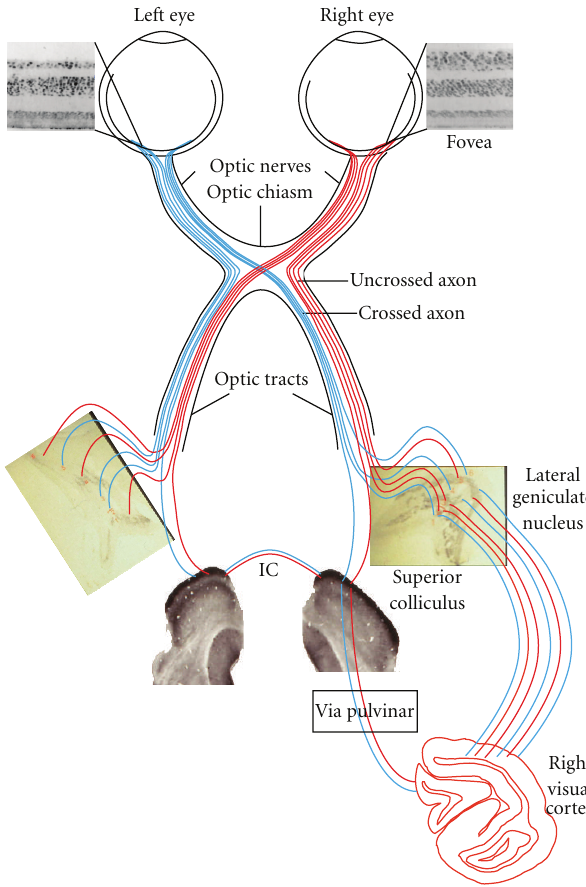
Figure 6: Suggested anatomical pathway for visual field recovery following early hemispherectomy (based on a series of anatomical studies performed on the same monkeys). The dea ff erented left temporal hemiretina (T) still contains ganglion cells [57] that send their axons to the remaining left dLGN as a dead end [12]. Retinofugal projections to the left superior colliculus (SC) are still robust and maintain a normal metabolic rate as measured by cytochrome oxydase immunochemistry [59]. The information reaching the left SC is transferred to the right SC via the intertectal commissure (IC), the right Pulvinar (P), and the occipital cortex of the remaining right hemisphere. The dea ff erented right nasal hemiretina (N) sends crossed projection through the optic chiasm (OC) to the appropriate layers of the remnants of the left dLGN and to the left SC [15, 58, 59, 62]. The left Pulvinar is severely atrophied and receives no retinal projections. Projections from the a ff erented portions of the retinae (left nasal and right temporal) reach their subcortical targets in a normal fashion en route to the occipital cortex of the right